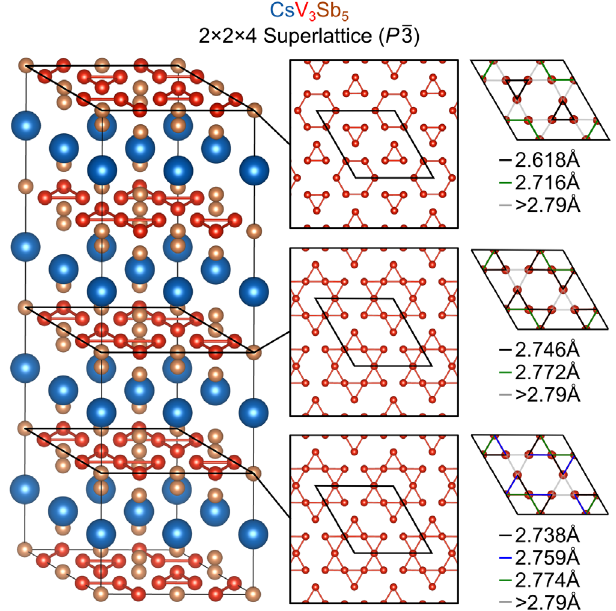
FIG. 3. Single-crystal diffraction data imply that CsV 3 Sb 5 distorts into a 2 × 2 × 4 supercell, where the kagome layers exhibit both TrH- and SoD-like distortions. Our current model ¯3 indexes the cell in the P space group. The SoD-like distortions are substantially weaker than the TrH-like distortion, and two unique SoD layers are